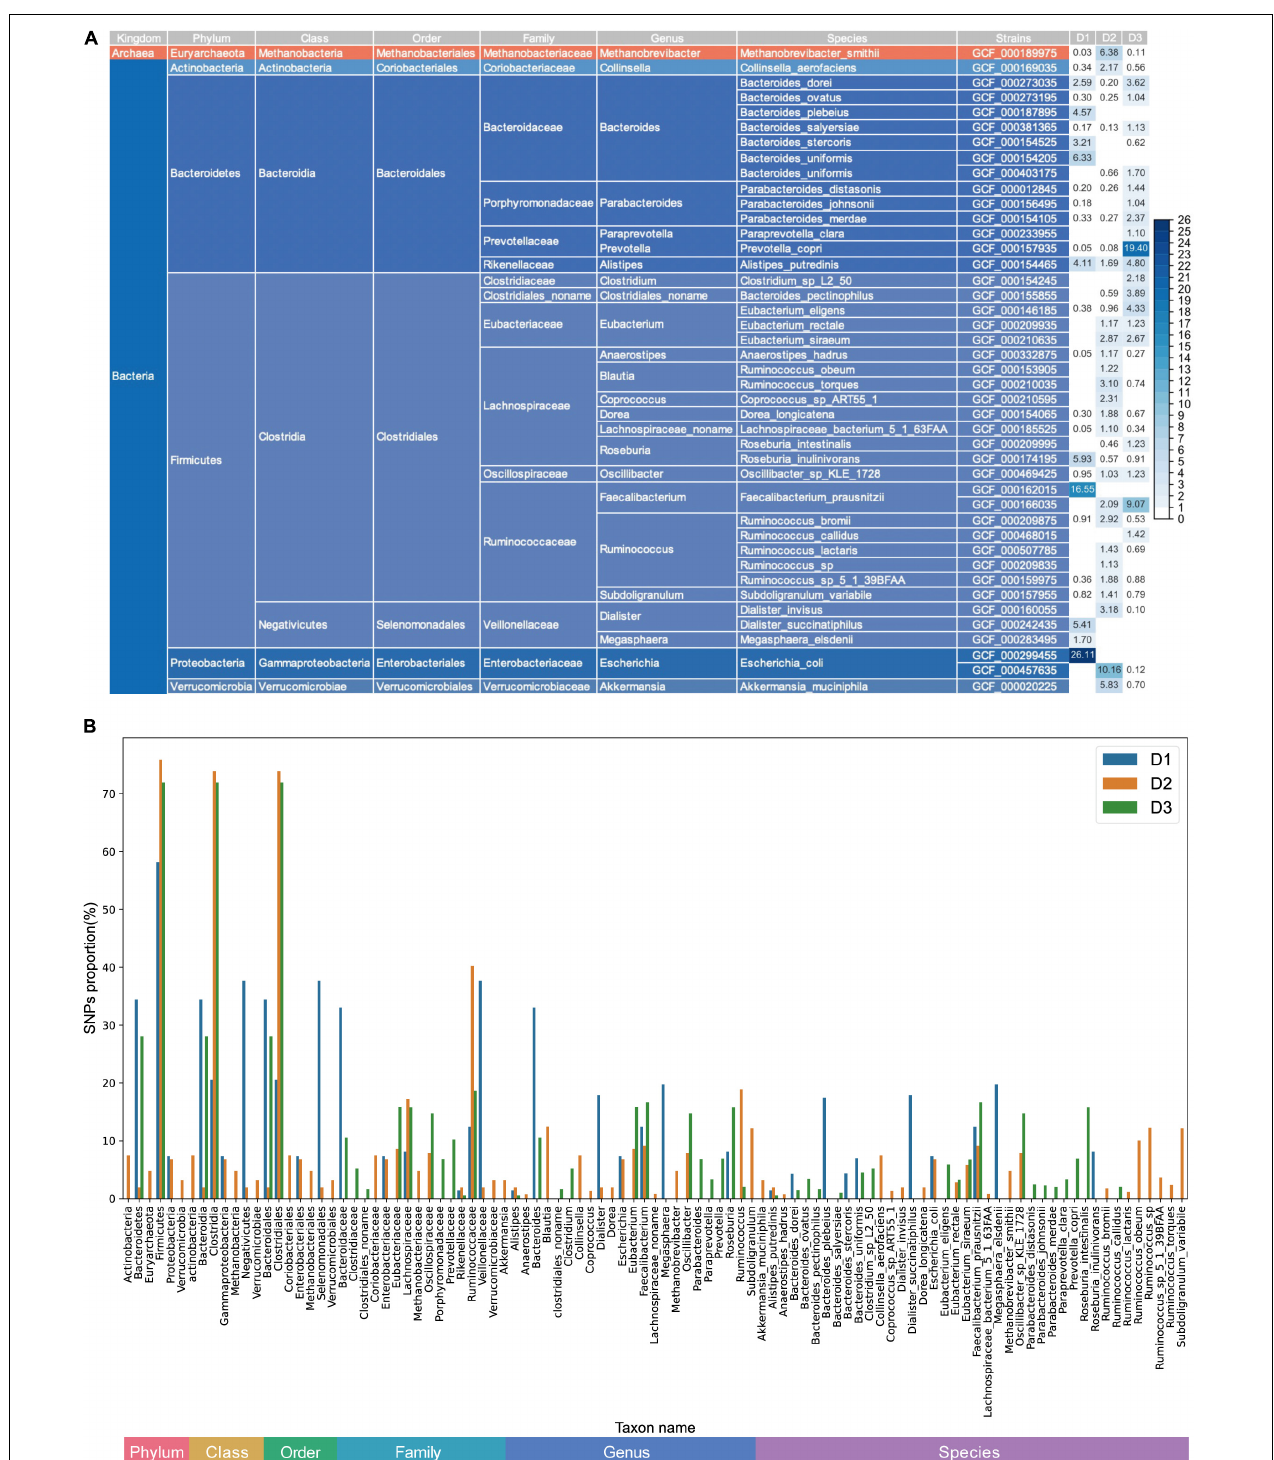
FIGURE 2 | Relative abundances and SNP profiles of dominant strains in ultra-deep sequenced samples. (A) Relative abundances of major strains and their corresponding taxonomies. The right part is the relative abundance (%) heatmap of these dominant strains in the three samples. The deeper the color, the higher the relative abundance. The left part of the panel shows the taxonomy structure of the dominant strains. (B) Bar plot depicting the proportions of SNPs (in percentage) identified from microbes at different taxonomic levels. The proportions of SNPs equal the number of SNPs at a particular taxonomic level divided by the number of total SNPs. At one taxonomic level, the proportions in each sample sum to